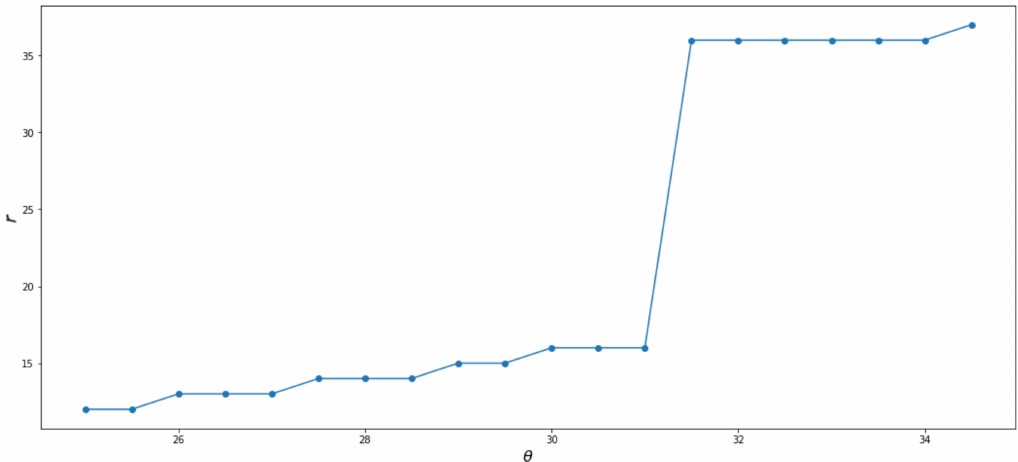
Figure 13. Distance to the first slope as function of θ . r L = 2.1 mm, r C = 3 mm, r R = 1.5